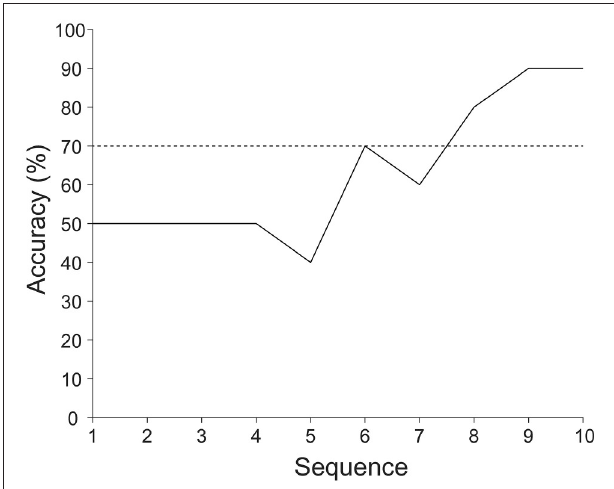
FIGURE 4 | Online and offline classification accuracies achieved by an ALS patient. The online and offline classification accuracies were calculated under same classifier with same data. The online classification accuracy was 90%, which is the same as the offline classification accuracy at sequence 10. Offline classification accuracy was computed by varying the number of sequences from 1 to 10. Also 70% classification accuracy is indicated by the horizontal dotted